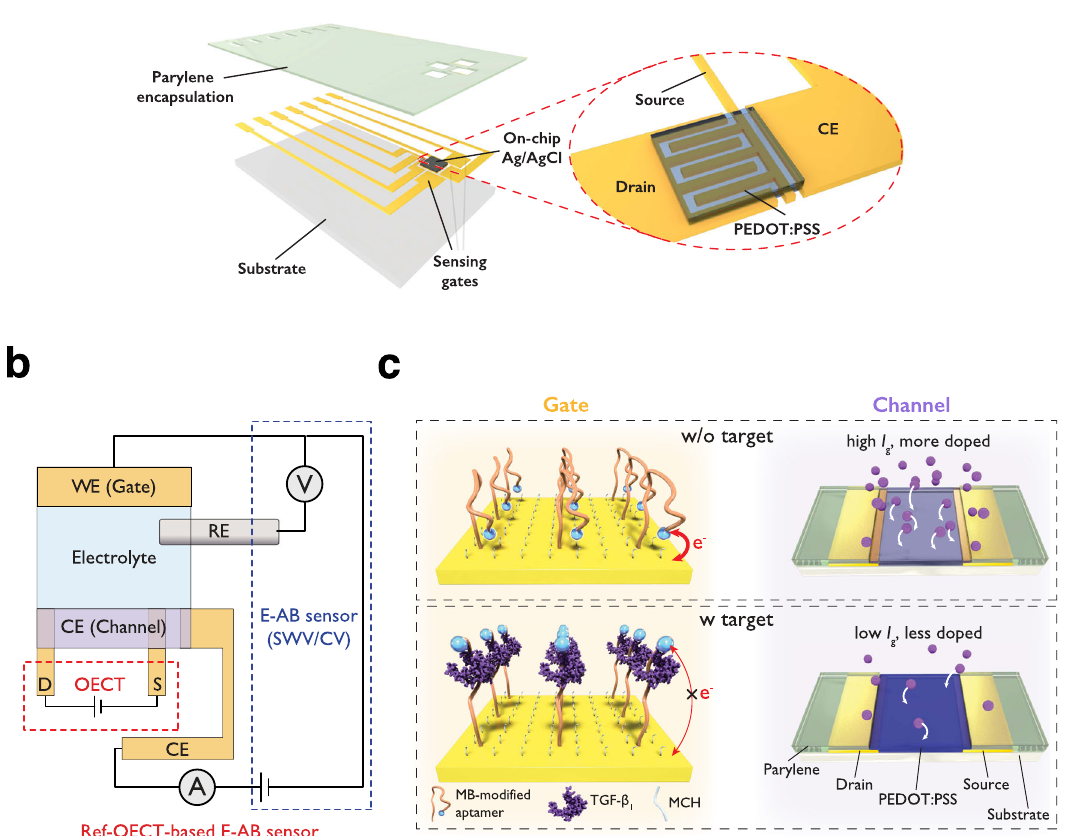
Fig. 1 | Design concept of ref-OECT-based E-AB sensor. a Schematic image of the ref-OECT-based E-AB sensor. b Testing scheme of the ref-OECT-based E-AB sensor. OutputofchannelcurrentinOECTcanbemonitoredduringtheoperationofE-ABsensorinthe3-electrodesetup. c Sensingmechanismoftheref-OECT-basedE-ABsensor forTGF- β 1 .WithouttheexistenceofTGF- β 1 ,themethyleneblue(MB)redoxreporterisclosertothegateelectrodesurface,whichresultsinahighgatecurrent( I G )aswellas a larger channel current modulation ( I DS ). In the presence of TGF- β 1 , a conformational change occursin the aptamer, and the MB redox reporter moves further from the gate electrode surface, which results in low gate current and smaller channel current